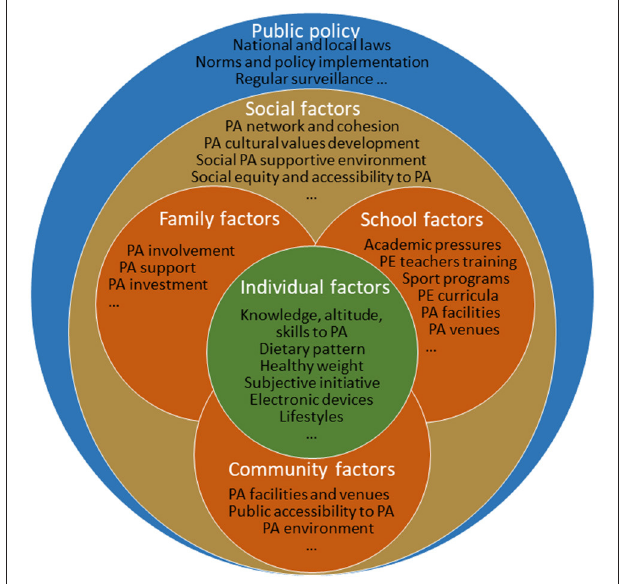
FIGURE 6 | The multilevel correlates of physical fitness improvement among children and adolescents based on the social ecological model.